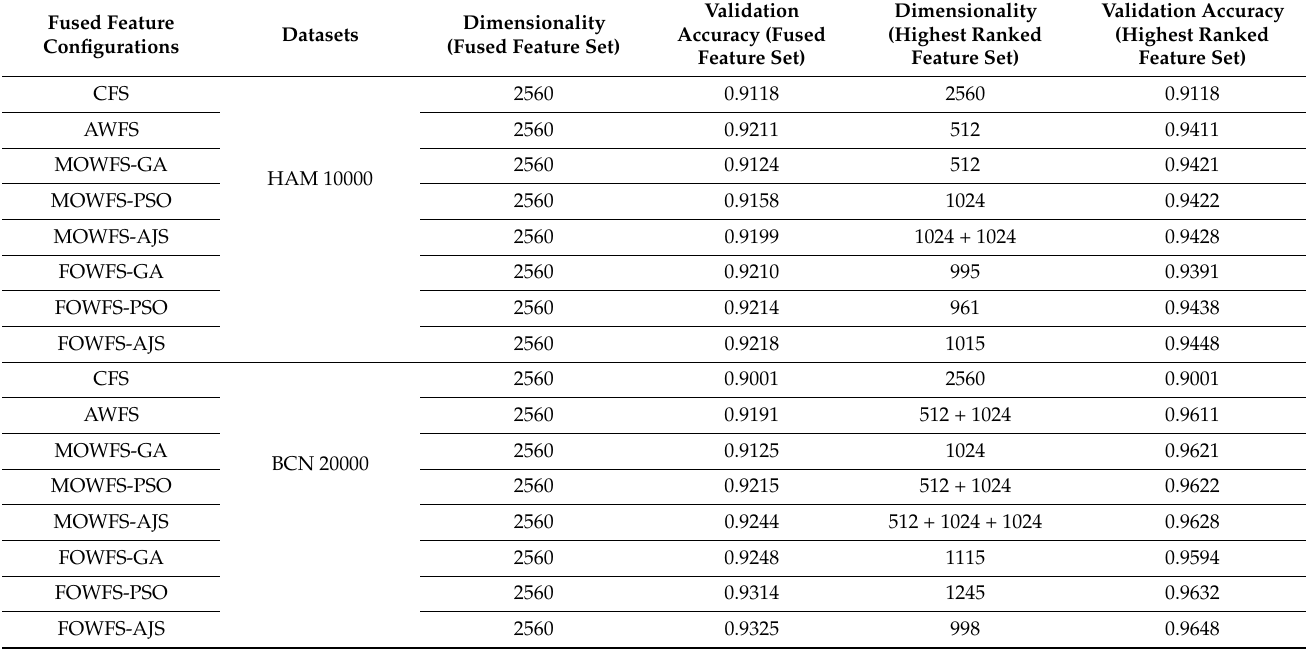
Table 5. Validation accuracy of fused feature sets vs. ranked feature sets based on